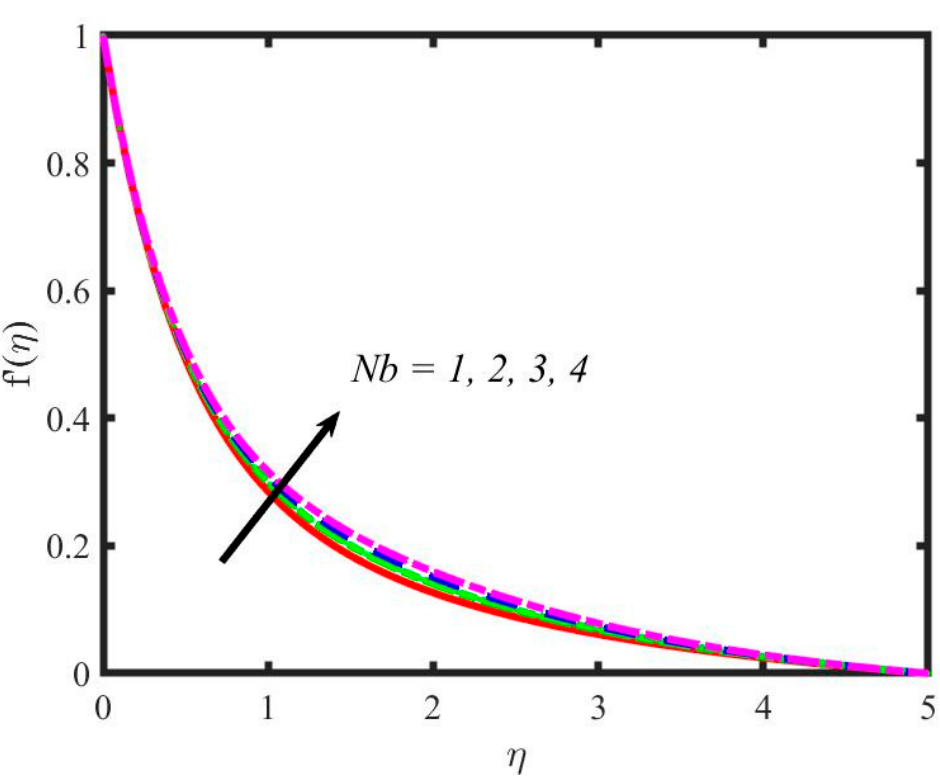
Figure 5. Variations in velocity for radiation parameter.